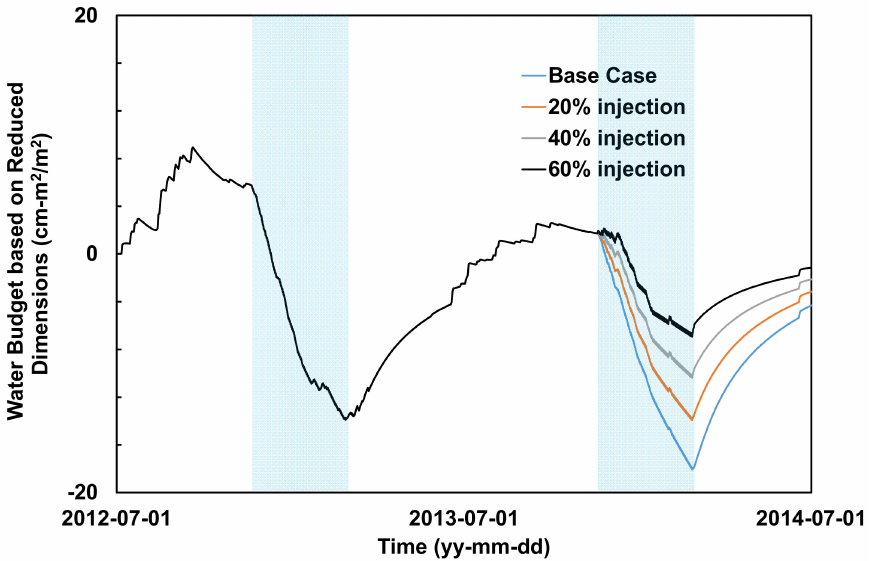
Figure 10. Comparison between the artificial recharge scenarios based on the aquifer storage model (Modified from Chang and Chung [24]) from September 2012 to June 2014 (blue boxes represent WCC